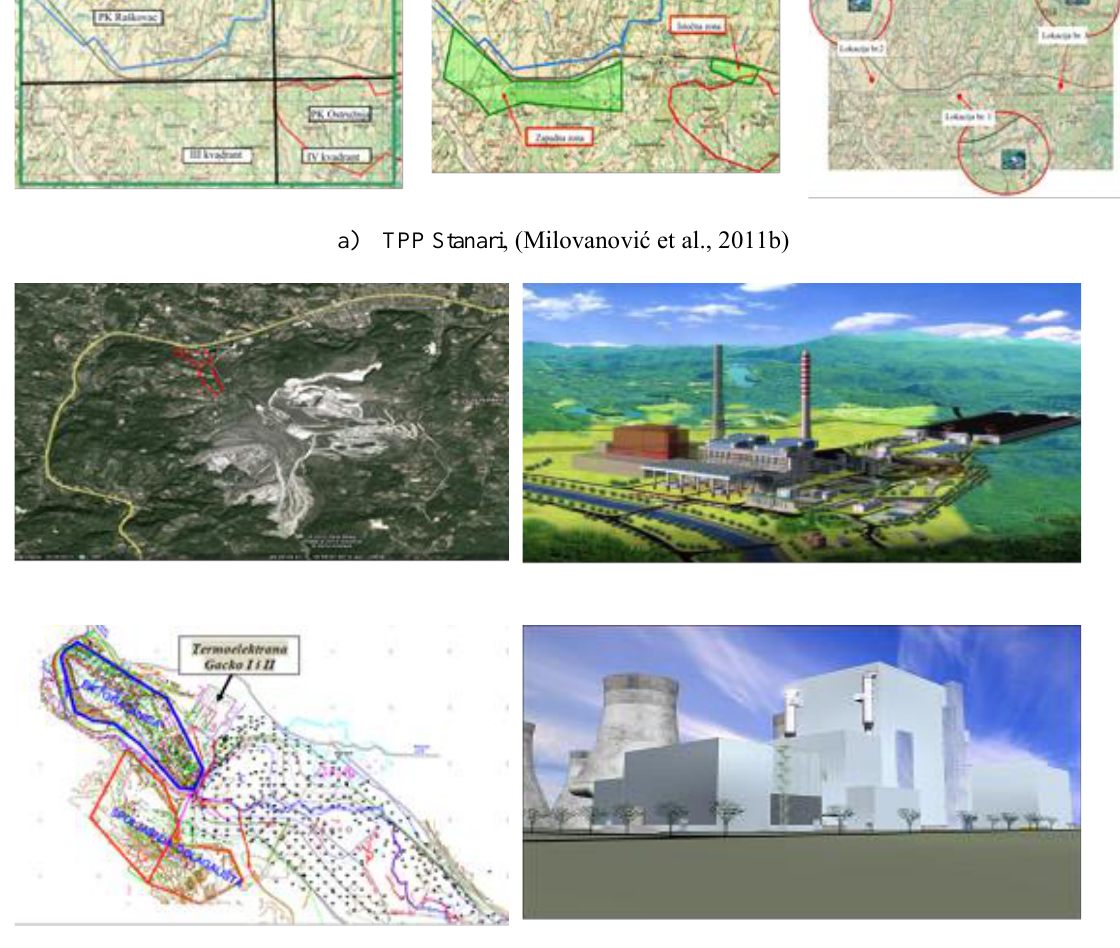
Figure 5. Satellite image and situational overview showing the space provided for the blocks of TPP Stanari, TPP Ugljevik 3 and TPP Gacko